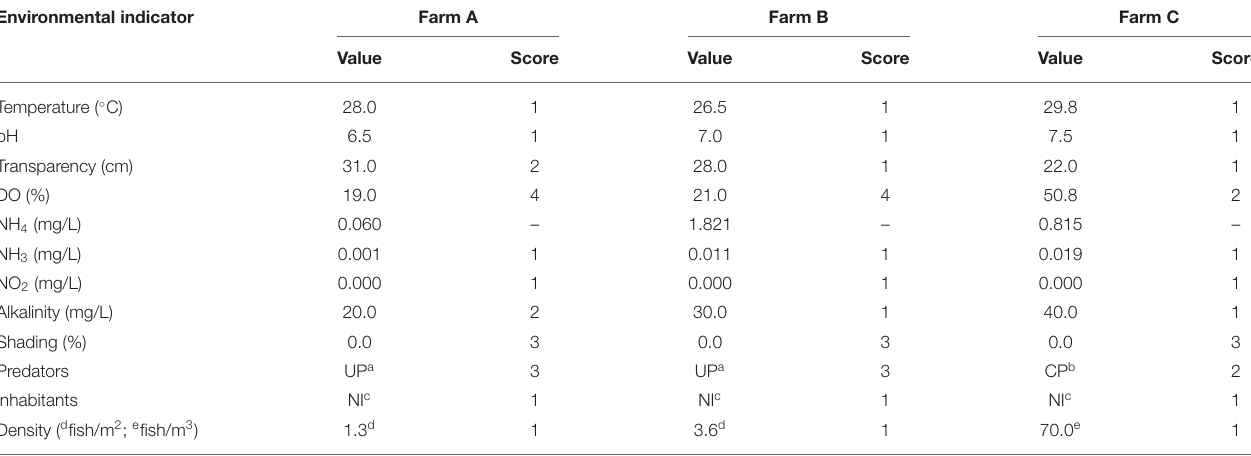
TABLE 7 | Environmental indicators values and scores of three different tilapia grow-out farms, data collected from January to March 2020 in South and Southeast Brazil. Environmental indicator